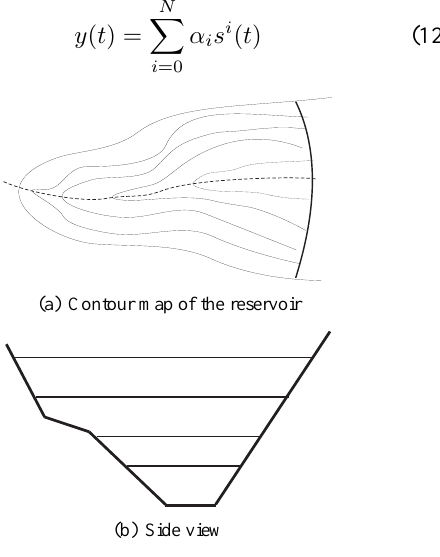
Fig. 3: Determination of the elevation-storage curve It should be noted that natural factors (for example sediment accumulation) will change the configuration of the reservoir over time and that the reservoir model needs to be updated